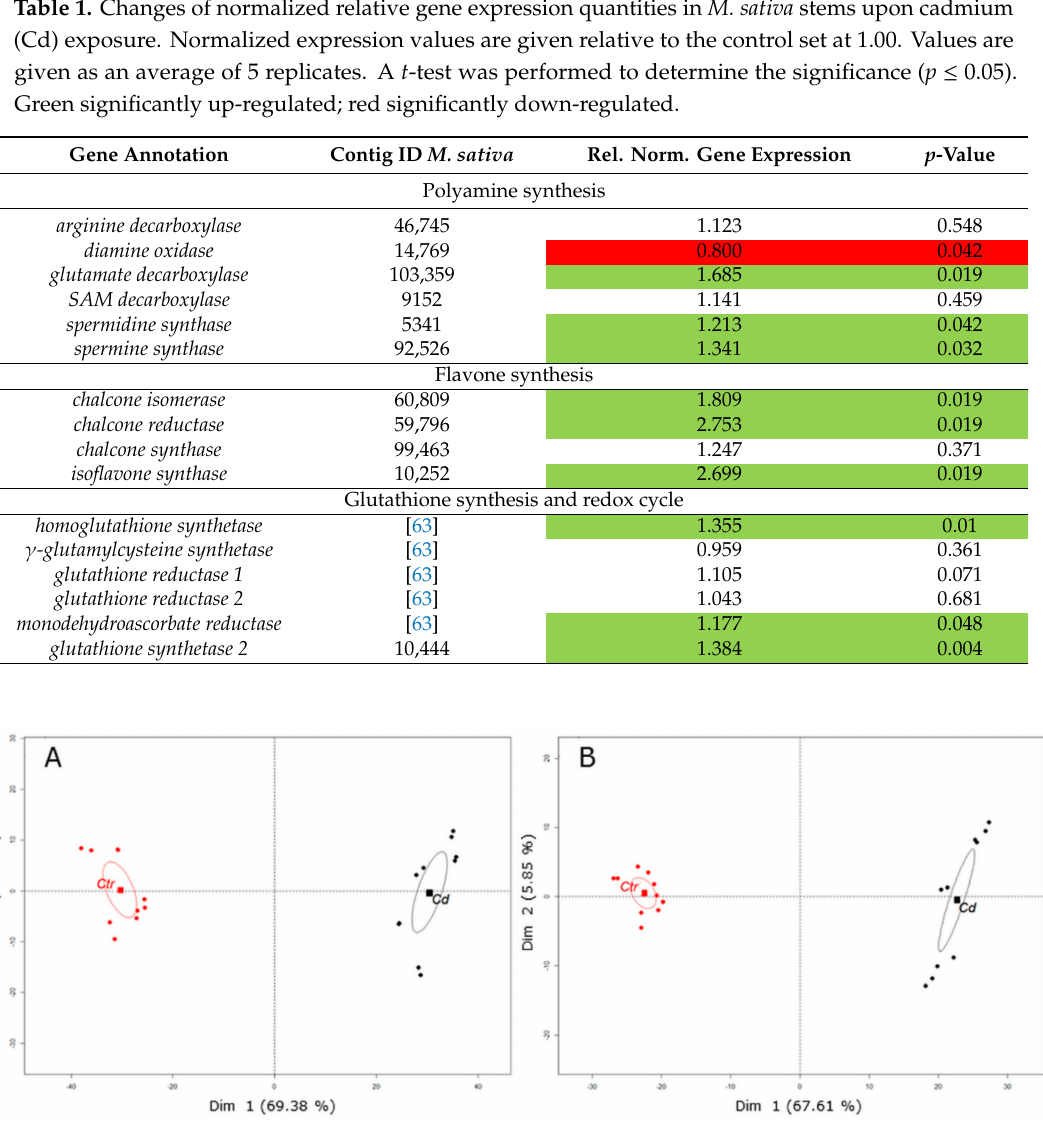
Figure 1. Plots of PCA revealed di ff erences of the secondary metabolite profiles in M. sativa stems after long-term Cd exposure (10 mg kg − 1 soil dry weight). Results show two distinct clusters of Cd-exposed (Cd) stem samples and control (Ctr) stem samples. Metabolites were measured by UPLC–MS in two technical replicates from five biological replicates. When samples were analyzed in ( A ) negative mode, Dim 1 and Dim 2 represent together 74.51% of the observed variance in the sample set. ( B ) In positive mode, Dim 1 and Dim 2 represent together 73.46% of the observed variance in the sample set. The barycenter of samples from control and Cd-exposed plants is indicated with a